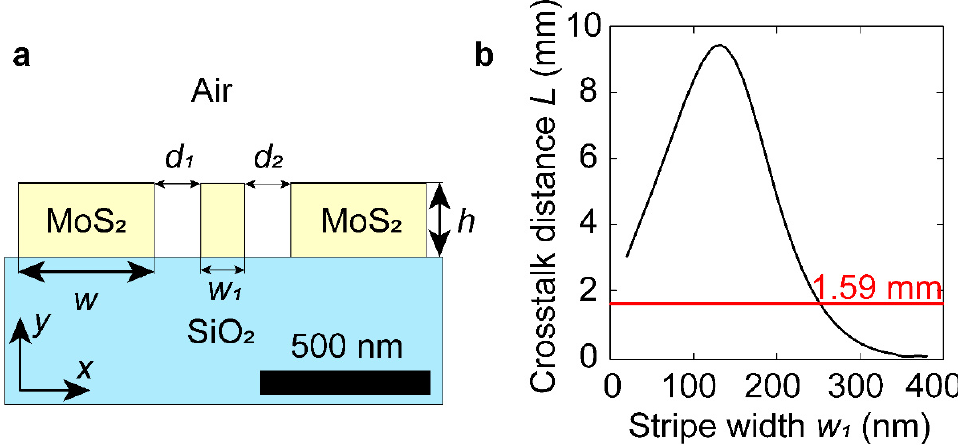
Figure 2. Single ‐ stripe structure. ( a ) Schematic view of the optimized structure. ( b ) Relation between the coupling length and the width of the stripe. The red line stands for coupling length in the initial structure with two waveguides and no additional stripes.